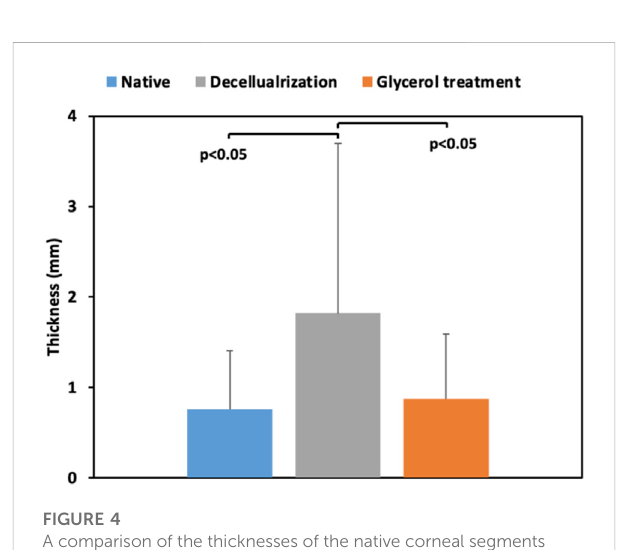
FIGURE 4 A comparison of the thicknesses of the native corneal segments (Native) with the scaffolds directly after decellularization (Decellularization) and post-treatment with glycerol (Glycerol